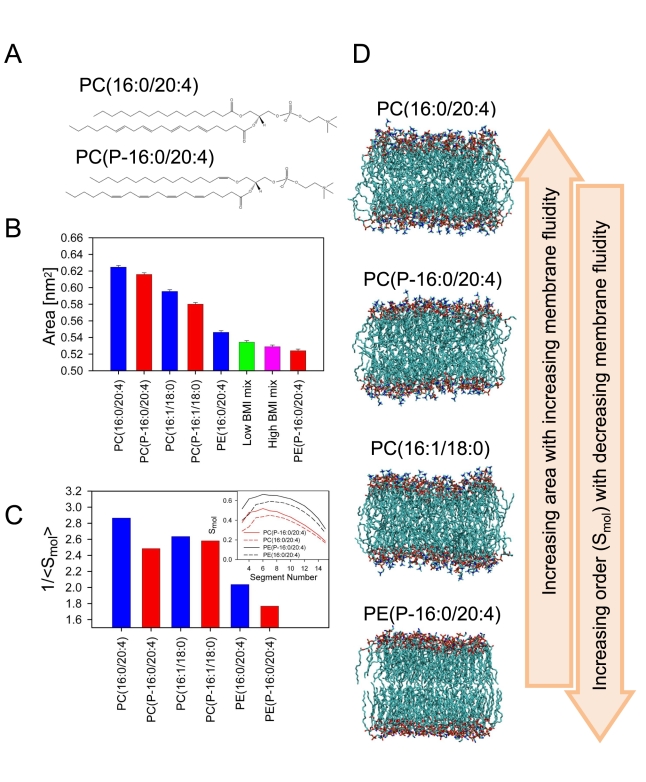
Large-scale molecular dynamics simulations of different lipid
membrane systems.Six single-lipid component systems were studied, representing major
groups of lipids found to be differentially regulated in acquired
obesity (Figure 1A).
Two lipid mixes, corresponding to observed concentration changes of most
abundant lipids (Figure
1B), were also studied to represent lipid membrane
composition in heavy and lean weight-discordant twins. (A) Structures of
two PUFA-containing PCs included in the simulations, one plasmalogen and
one ester-bonded. (B) Average area per lipid of the eight simulated
bilayer systems, indicating the packing or fluidity of the bilayer
(smaller area means decreased fluidity). (C) The molecular order
parameter (S
mol) profiles along selected
unsaturated acyl chains. Segment number means the carbon position
starting from ester-vinyl linkage and ending at the methyl group in the
end of the chain. (D) Snapshots from the end of four simulations, with
the lipids ordered from top to bottom according to decreased fluidity
(area per lipid parameter from [B]).